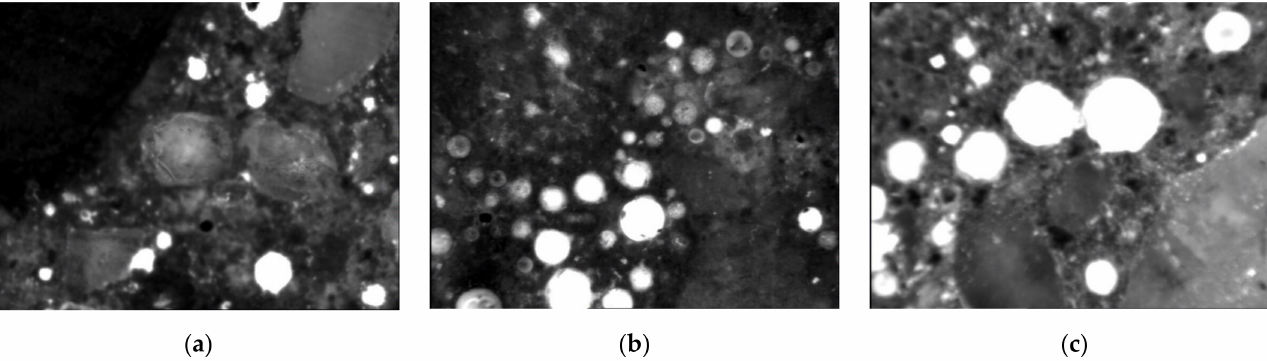
Figure 5. Air voids distribution (marked in white) at the cross-section of concrete specimens at 28 days: ( a ) 0% FAM; ( b ) 2.6% FAM with grains size < 200 µ m; ( c ) and 2.6% FAM with grains size < 500 µ